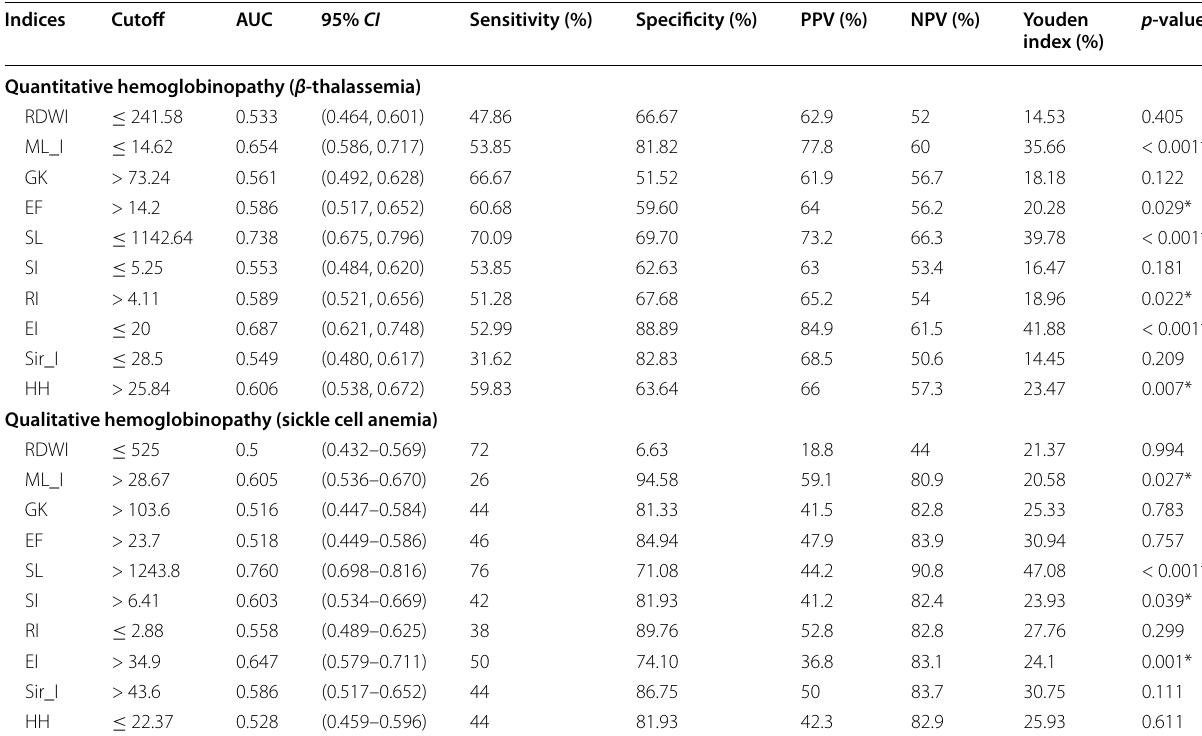
Table 2 The curve of receiver operating characteristic (ROC) of the studied indices for optimum cutoff points in differentiating the study hemoglobinopathy groups from each other